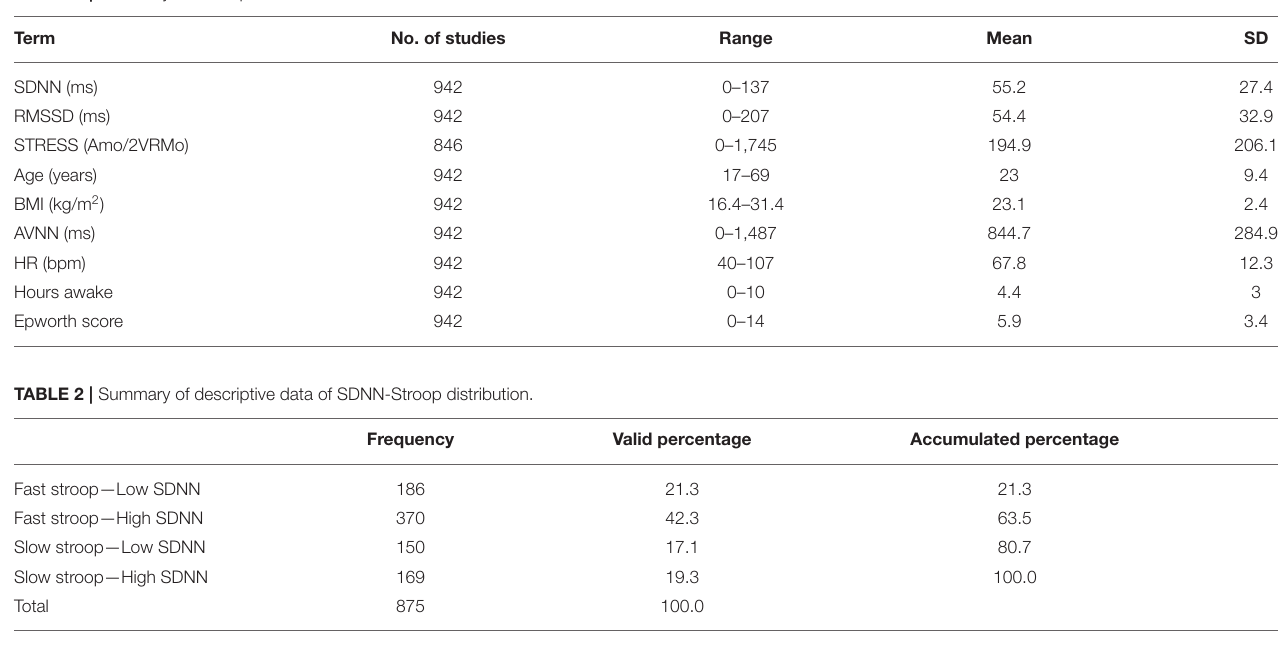
TABLE 1 | Summary of descriptive data.